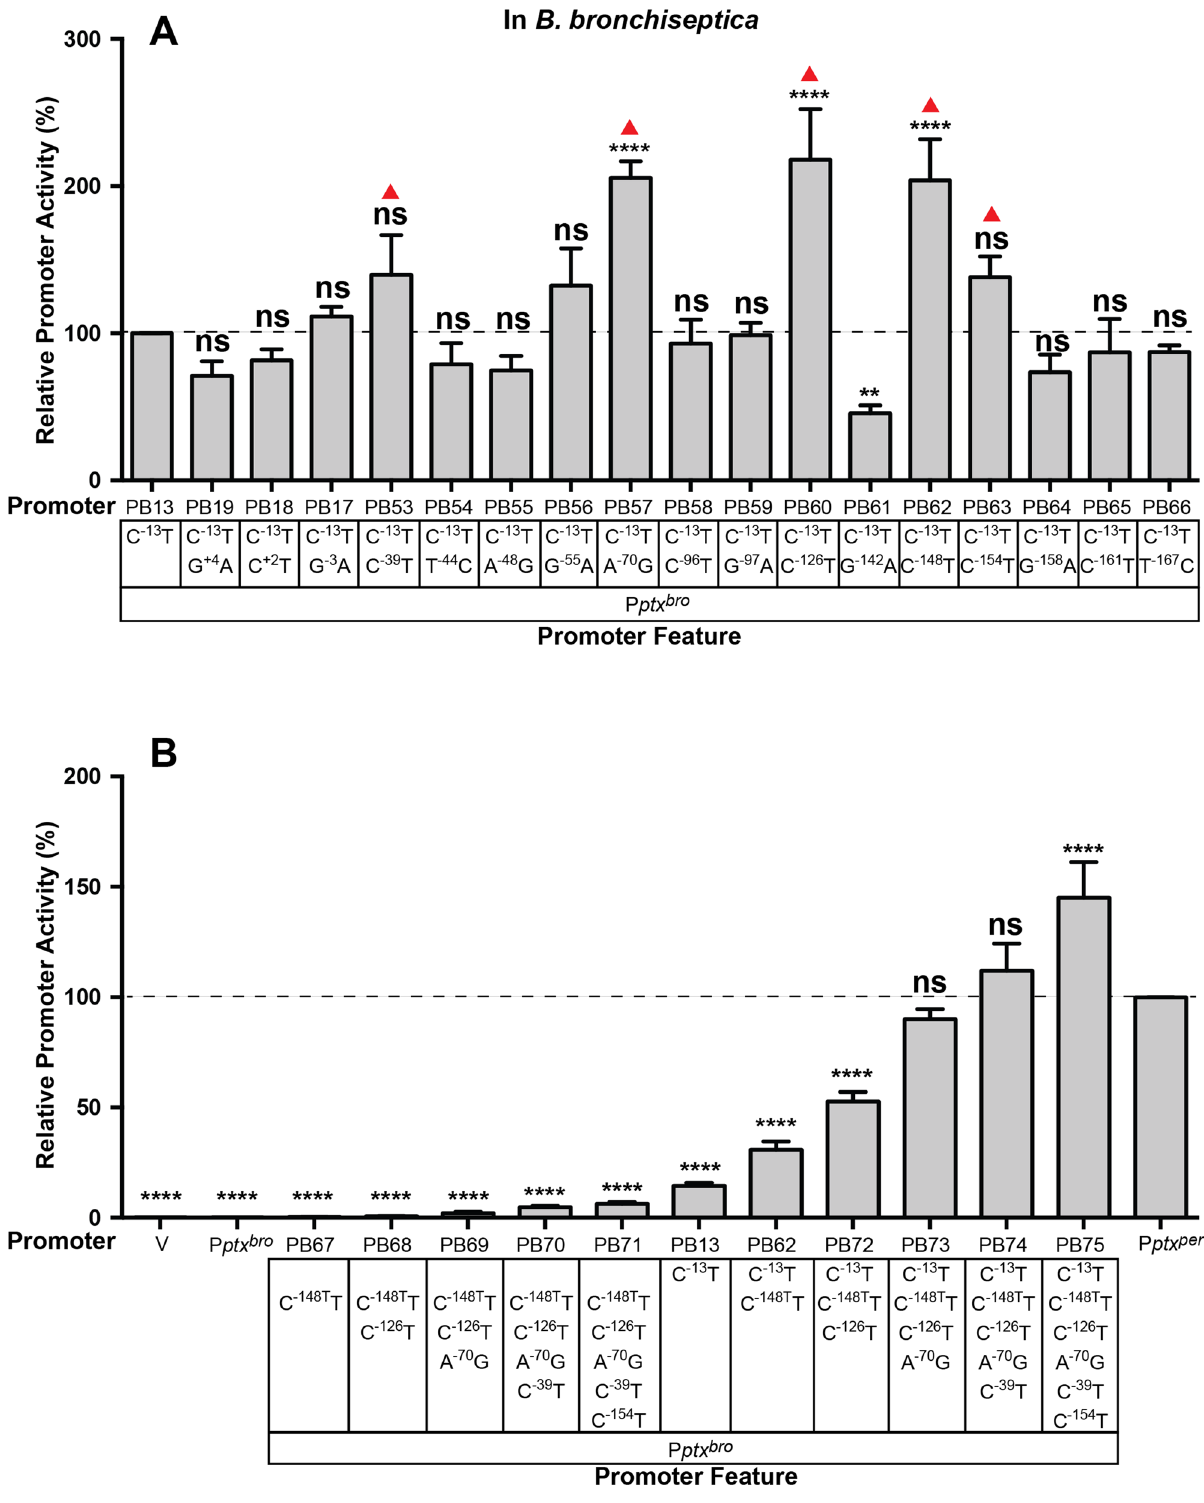
Figure 5. Assessment of the impact of individual SNPs in the BvgA-binding region on the function of P ptx bro and P ptx bro C −13 T. Plasmids containing various hybrid promoters fused to luxCDABE in vector pSS3967 were integrated into B. bronchiseptica RB50 to generate ectopic fusions, and the resulting light output was measured as described in Fig. 4. SNPs present in each promoter are shown in the boxes below each graph. ( A ) The P ptx per versions of each SNP in the BvgA-binding region were introduced singly into P ptx bro C −13 T. Five of these, which had the greatest effect and are marked in red triangle, were chosen for further analysis. ( B ) The five SNPs identified in ( A ) were introduced stepwise, in an additive fashion, into P ptx bro , as in hybrid promoters PB67–PB71 or into P ptx bro C −13 T, as in hybrid promoters PB62 and PB72–PB75. The wild type P ptx bro , P ptx per , and vector (V) controls, as well as methods for data analysis using the values from PB13 ( A ) or P ptx per ( B ) as a control group, are as in Fig.